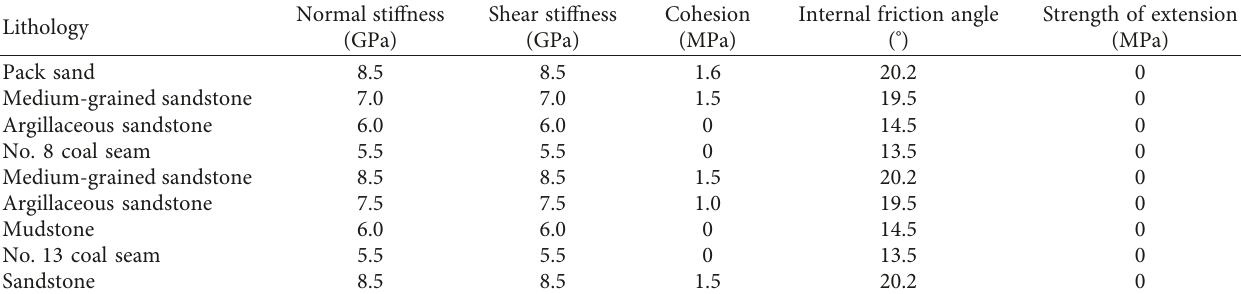
Table 3: The mechanical parameters of the contact surface of coal and rock.